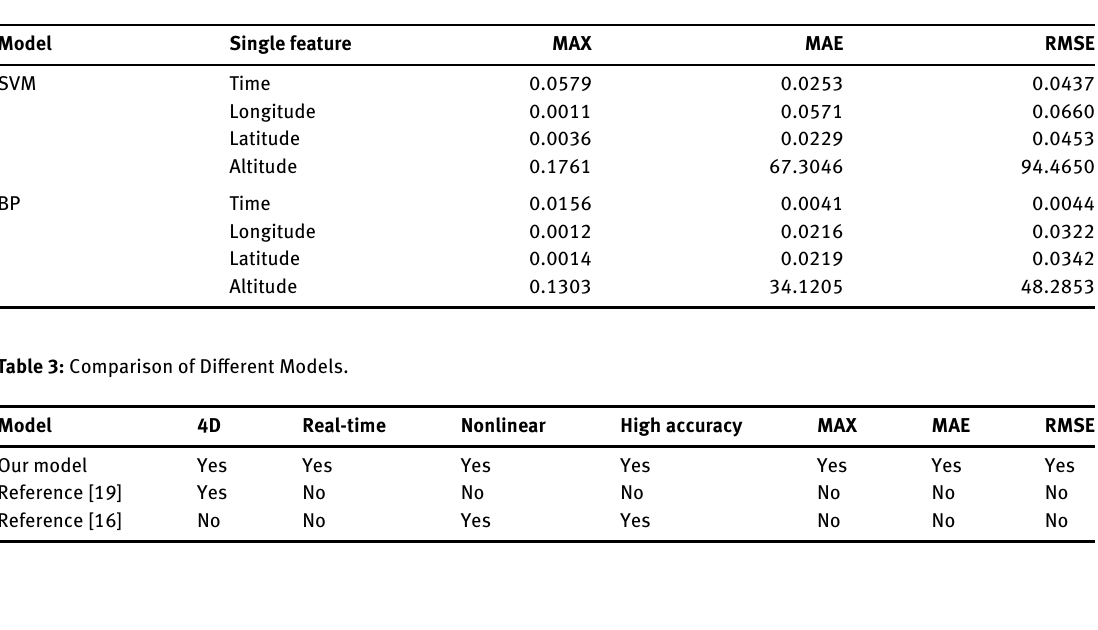
Table 2: Comparison of Model Prediction Accuracy.